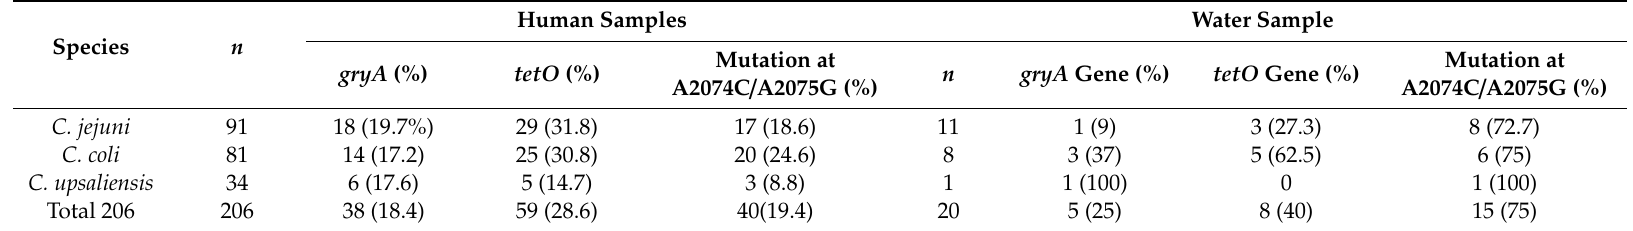
Table 6. Distribution of antibiotic resistance genes in Campylobacter